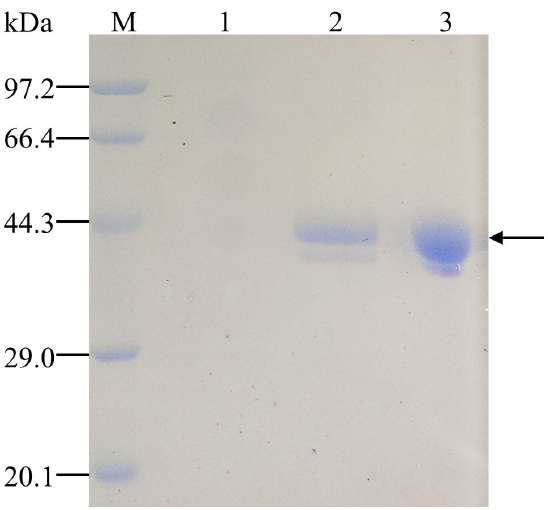
Figure 1. SDS-PAGE analysis of pePGA. Lane M, the standard protein markers (low); lane 1, the culture supernatant of empty vectors; lane 2, the culture supernatant of pePGA; lane 3, purified recombinant pePGA.